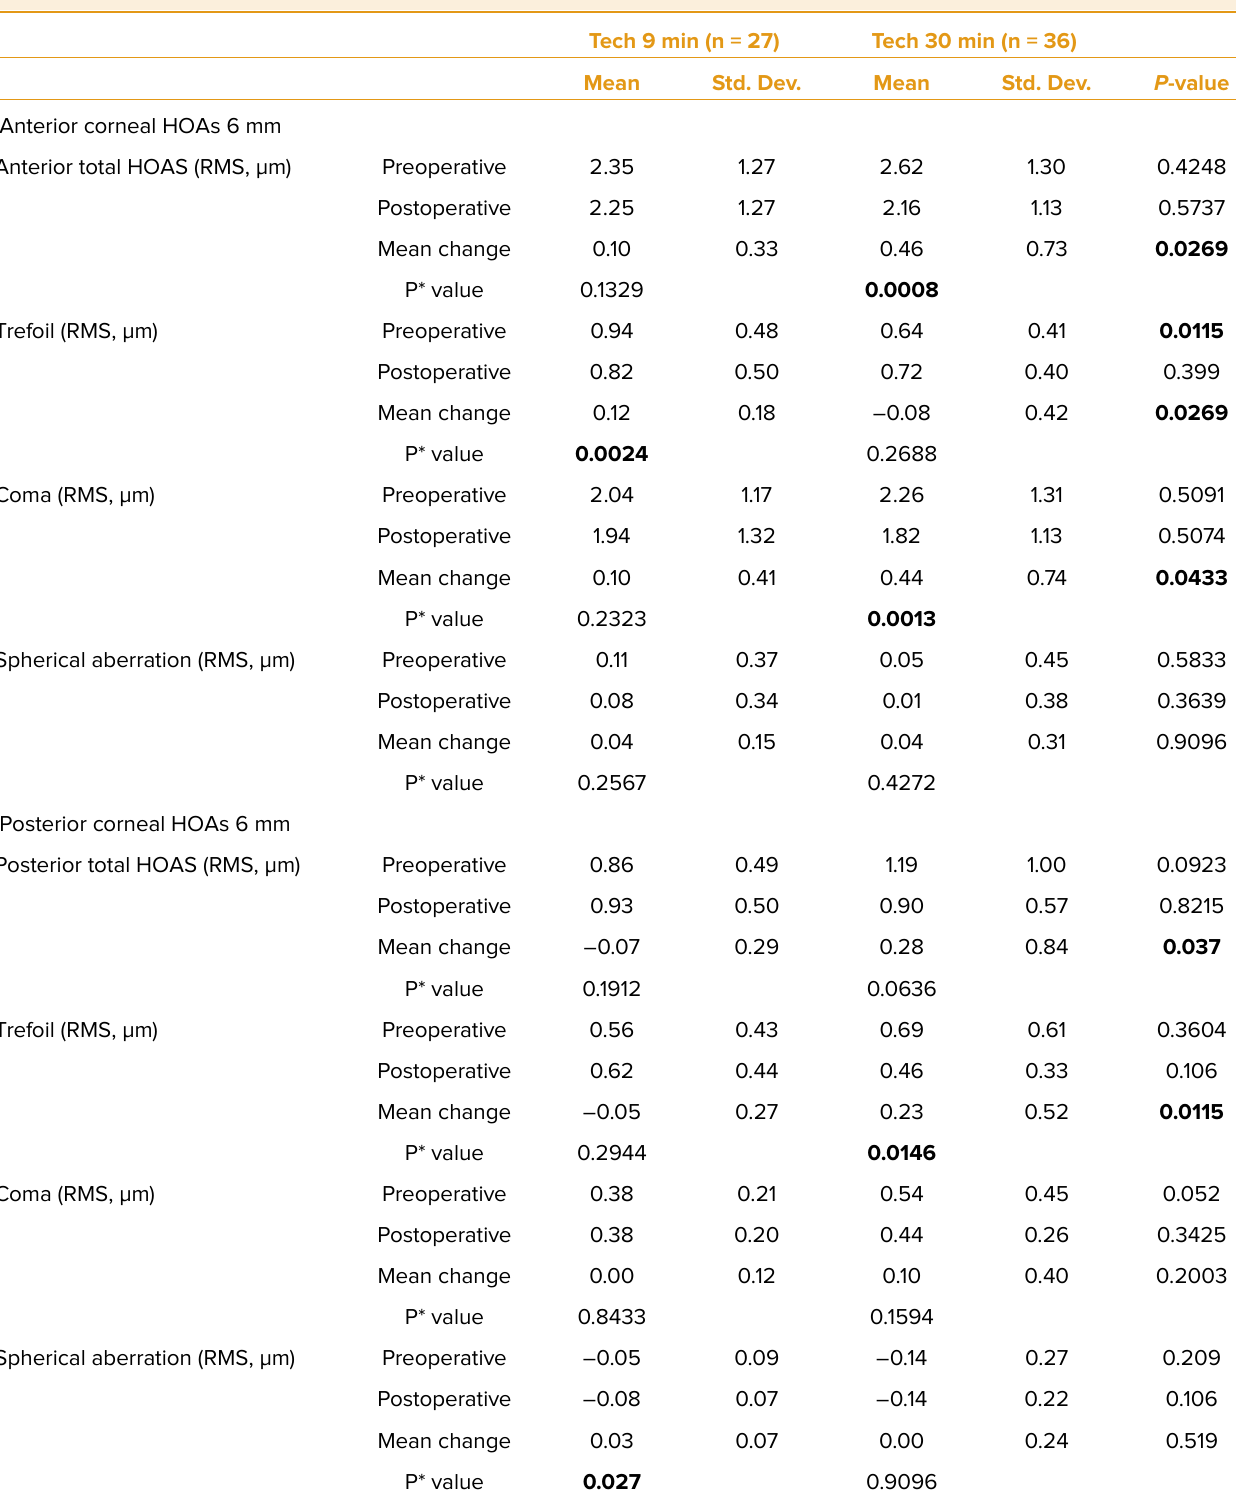
Table 4. Anterior and posterior corneal HOAS